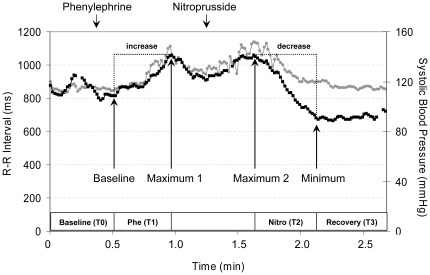
Exemplified time course of systolic blood pressure (black line) and R-R interval (grey line) during the modified Oxford maneuver.